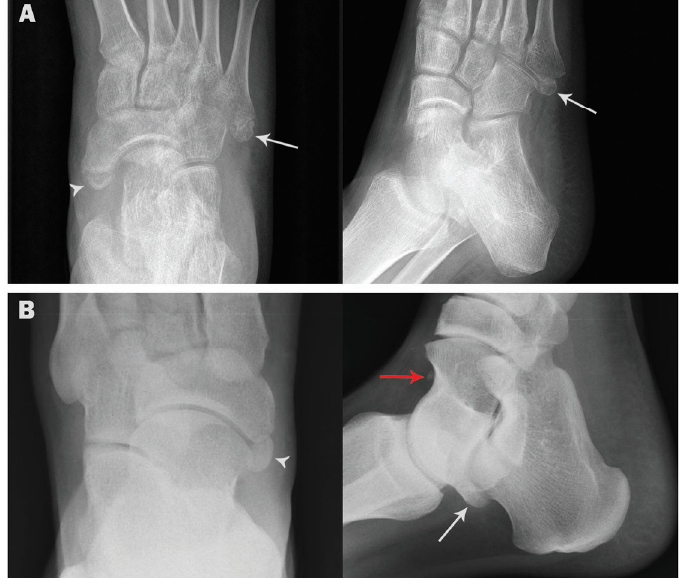
Figure 4. Coexistence of accessory navicular and other ossicles in the same foot. ( A ). AP and oblique radiographs showing accessory navicular (arrowhead) and os vesalianum (arrow) in a 56 ‐ year ‐ old female. ( B ). AP and lateral radiographs showing accessory navicular (arrowhead), os trigonum (white arrow) and os supratalare (red arrow) in a 45 ‐ year ‐ old male.